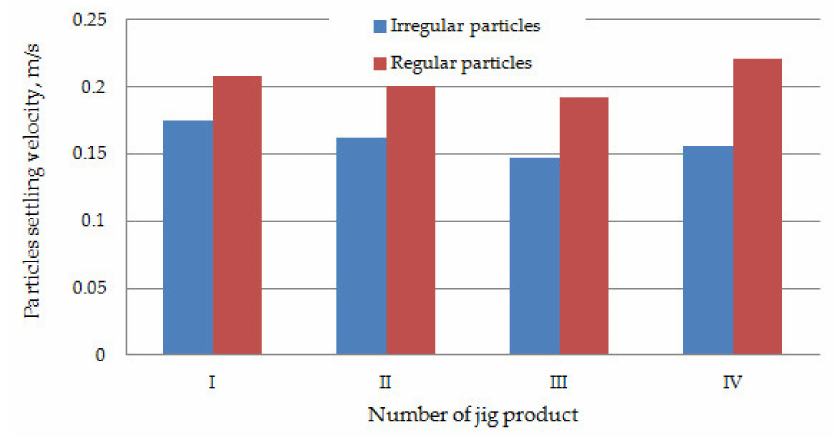
Figure 8. The relation between the settling velocity of particles for the separation products.